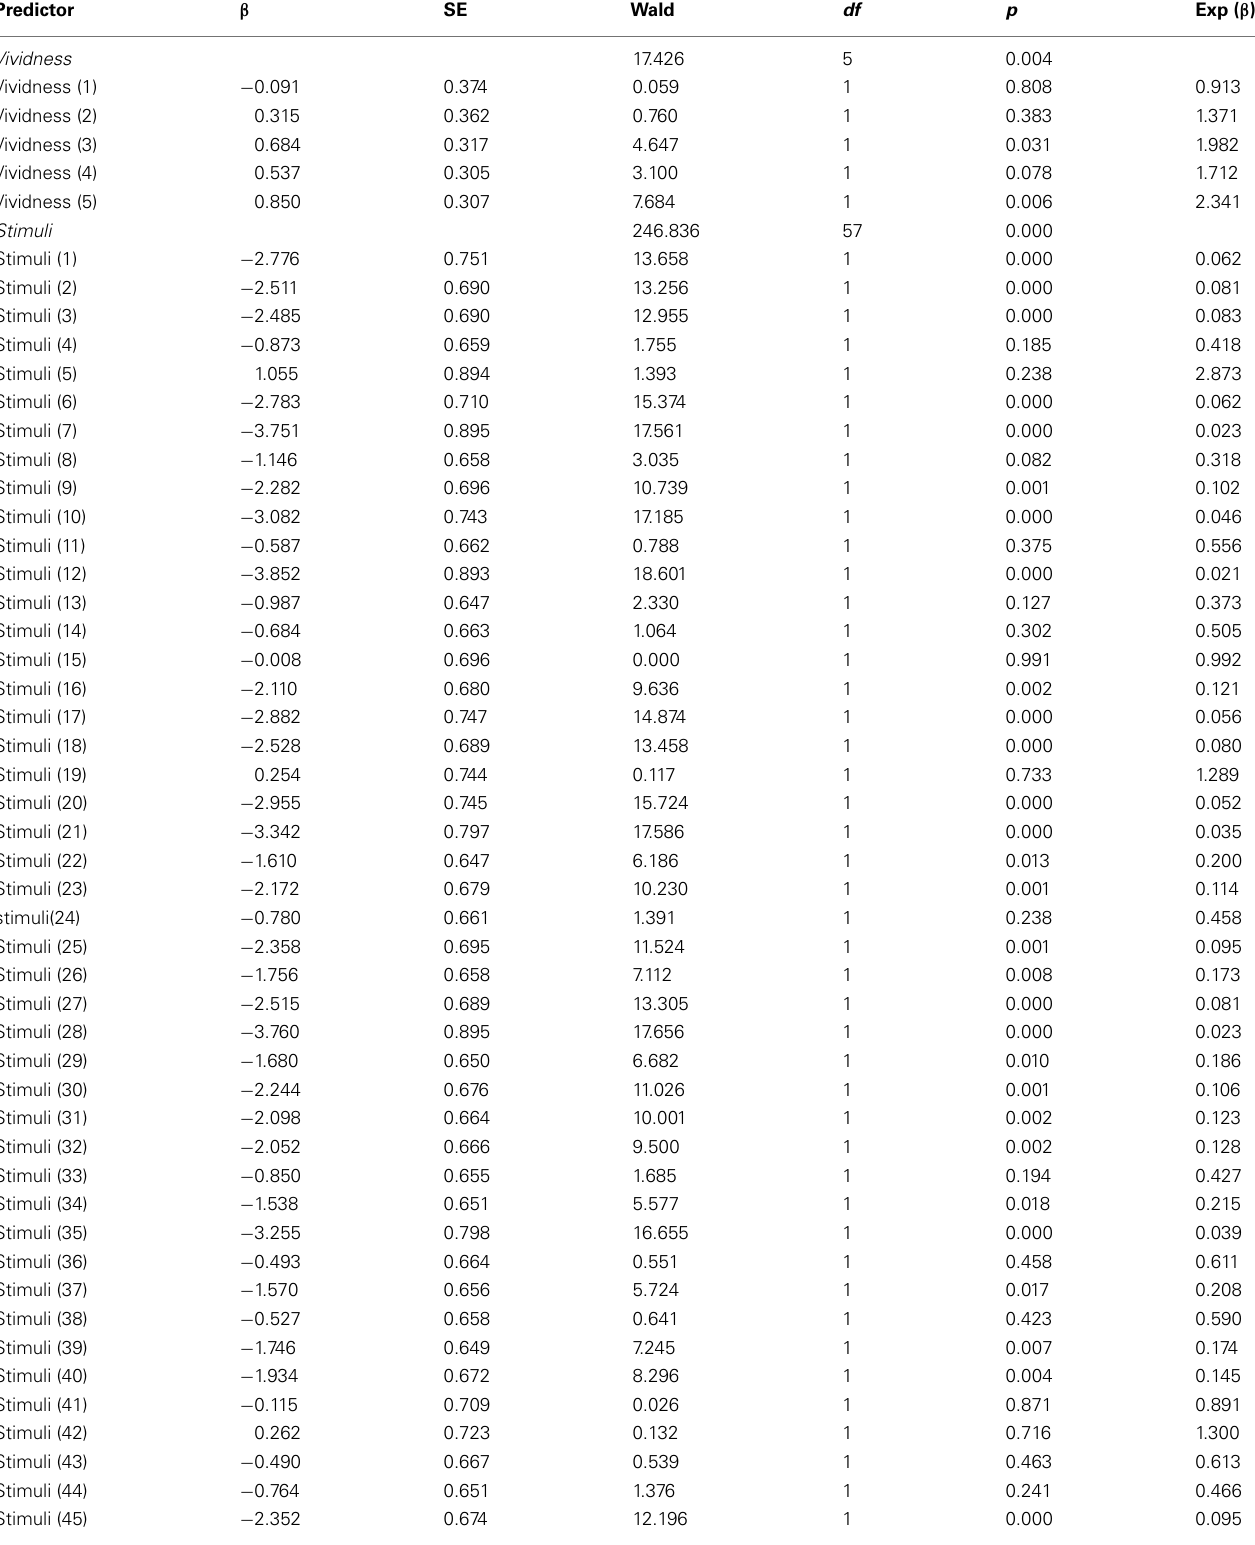
TableA4 | Logistic regression analysis of vividness and incidental recall